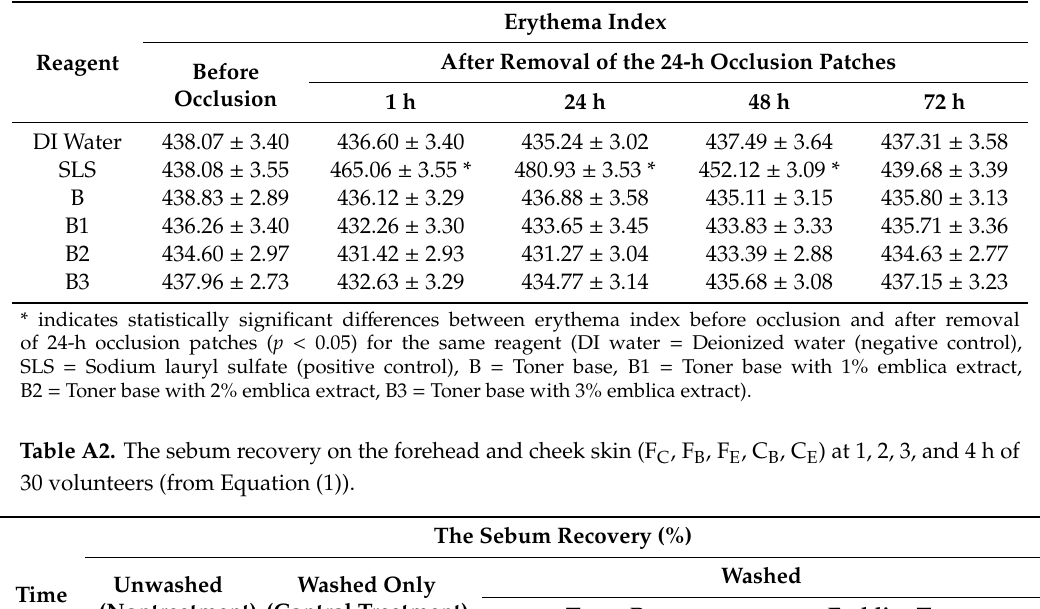
Table A1. Erythema index of skin Irritation test.